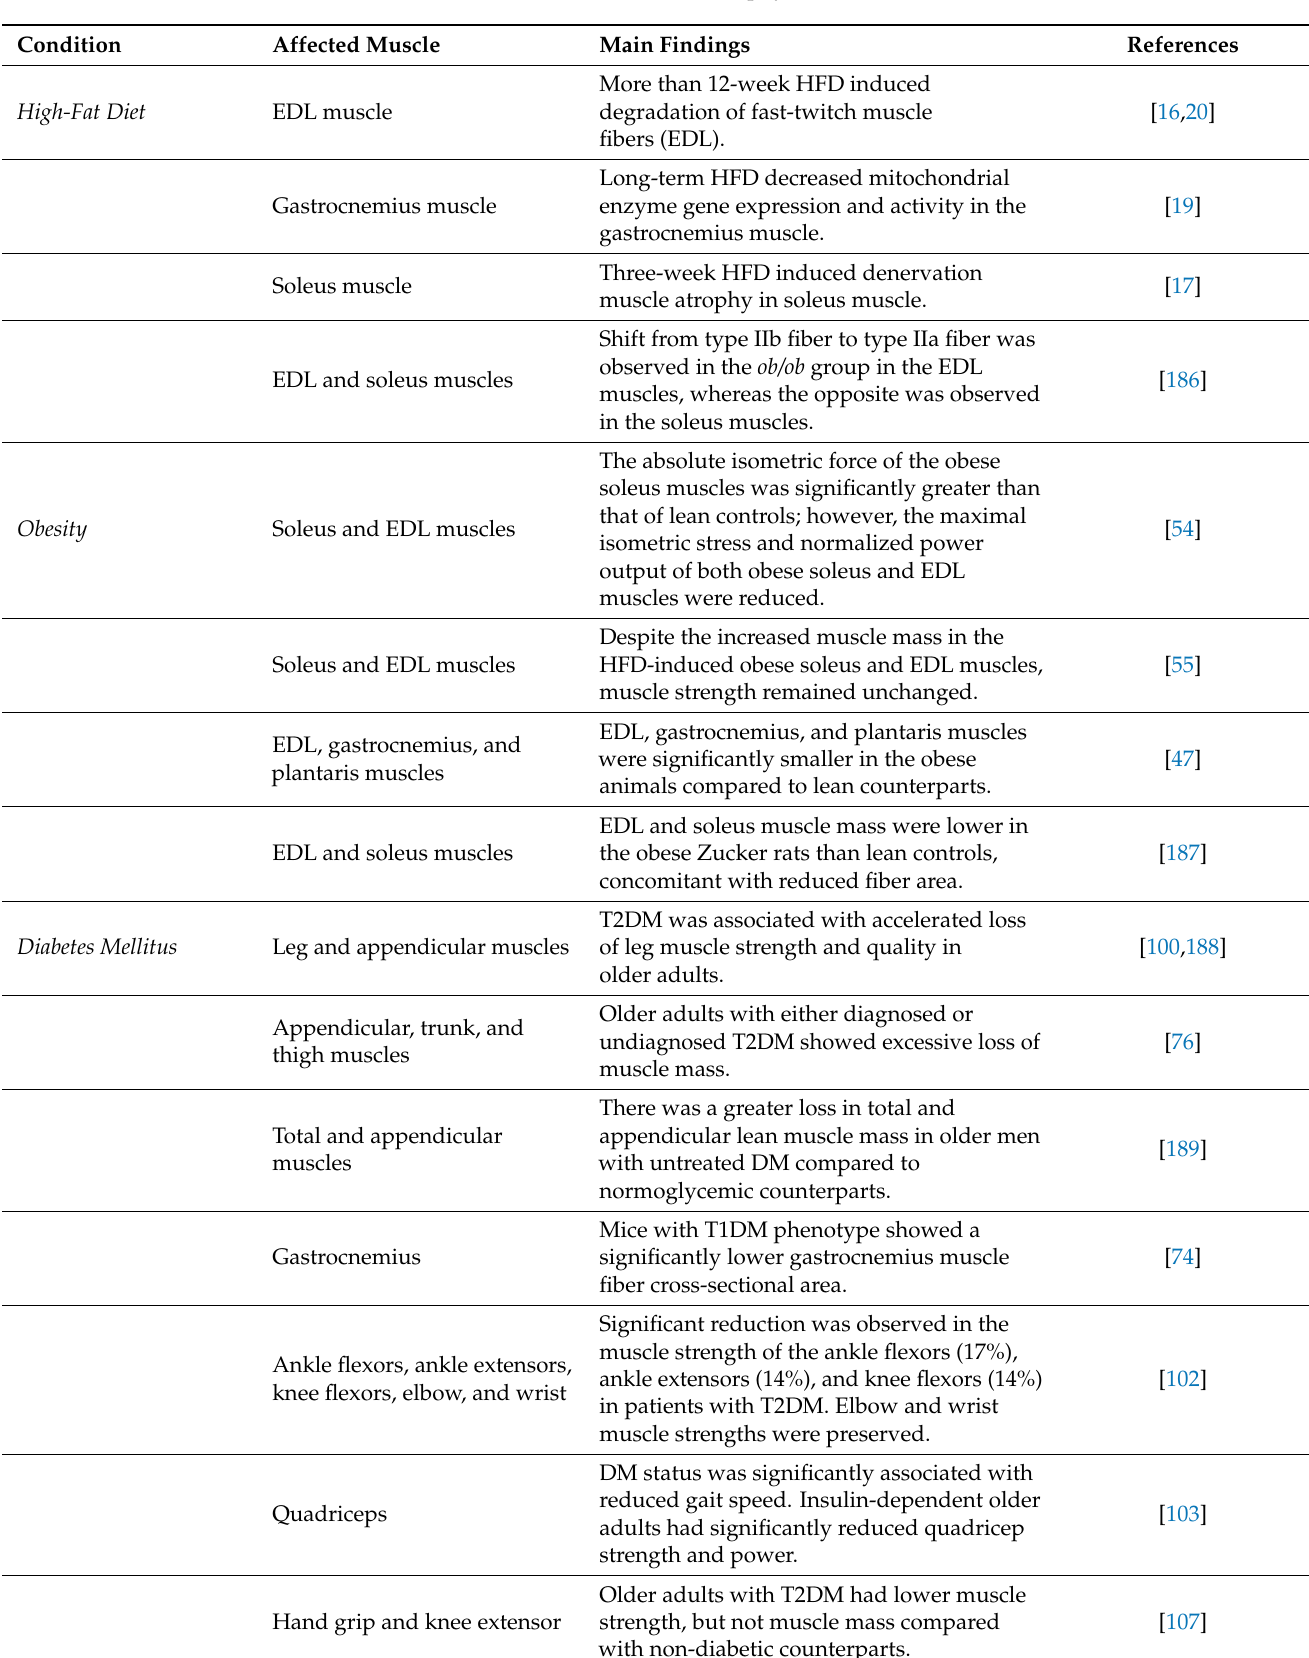
Table 1. Prevalence of skeletal muscle